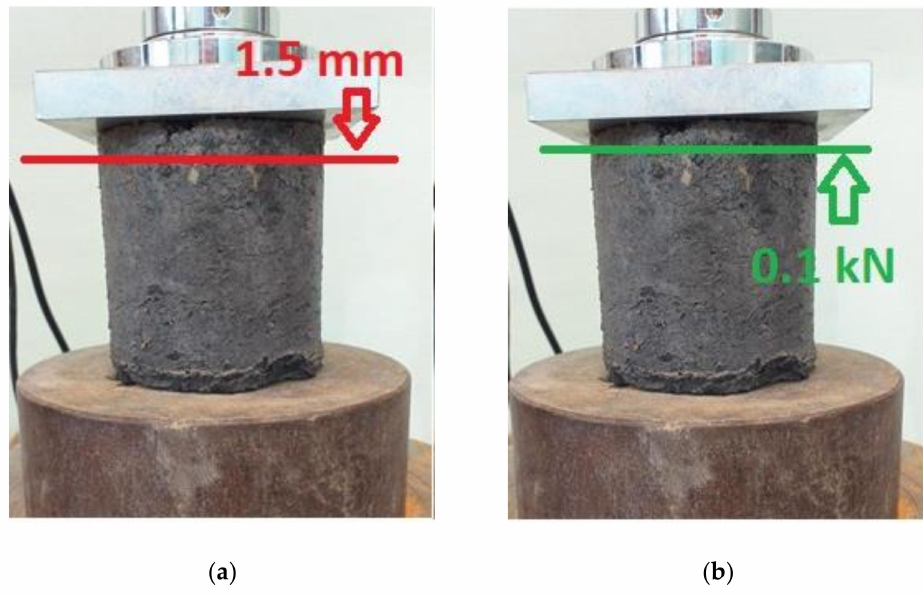
Figure 5. Diagram of ( a ) the loading and ( b ) the unloading cycle of the tested specimens (photo: K.